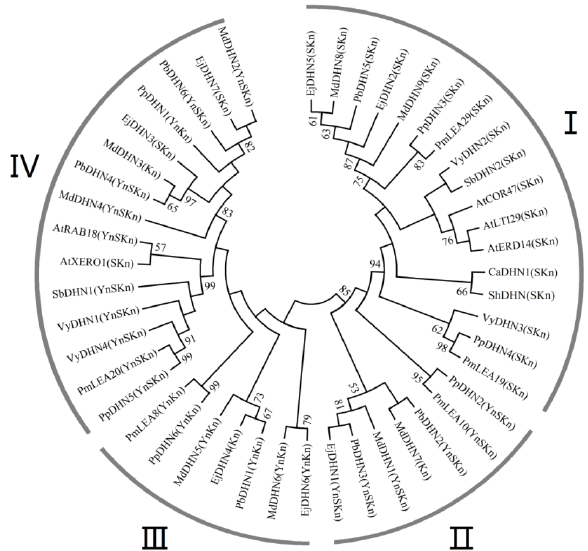
Figure 3. Phylogenetic tree analysis of DHNs from different plant species. The unrooted phylogenetic tree was constructed using MEGA 5.0 with the neighbor-joining method. The bootstrap test was performed with 1000 replicates. Percentage bootstrap scores of >50% were displayed. vThe results revealed that DHN proteins from different species could be roughly divided into four groups: I, II, III, and IV.